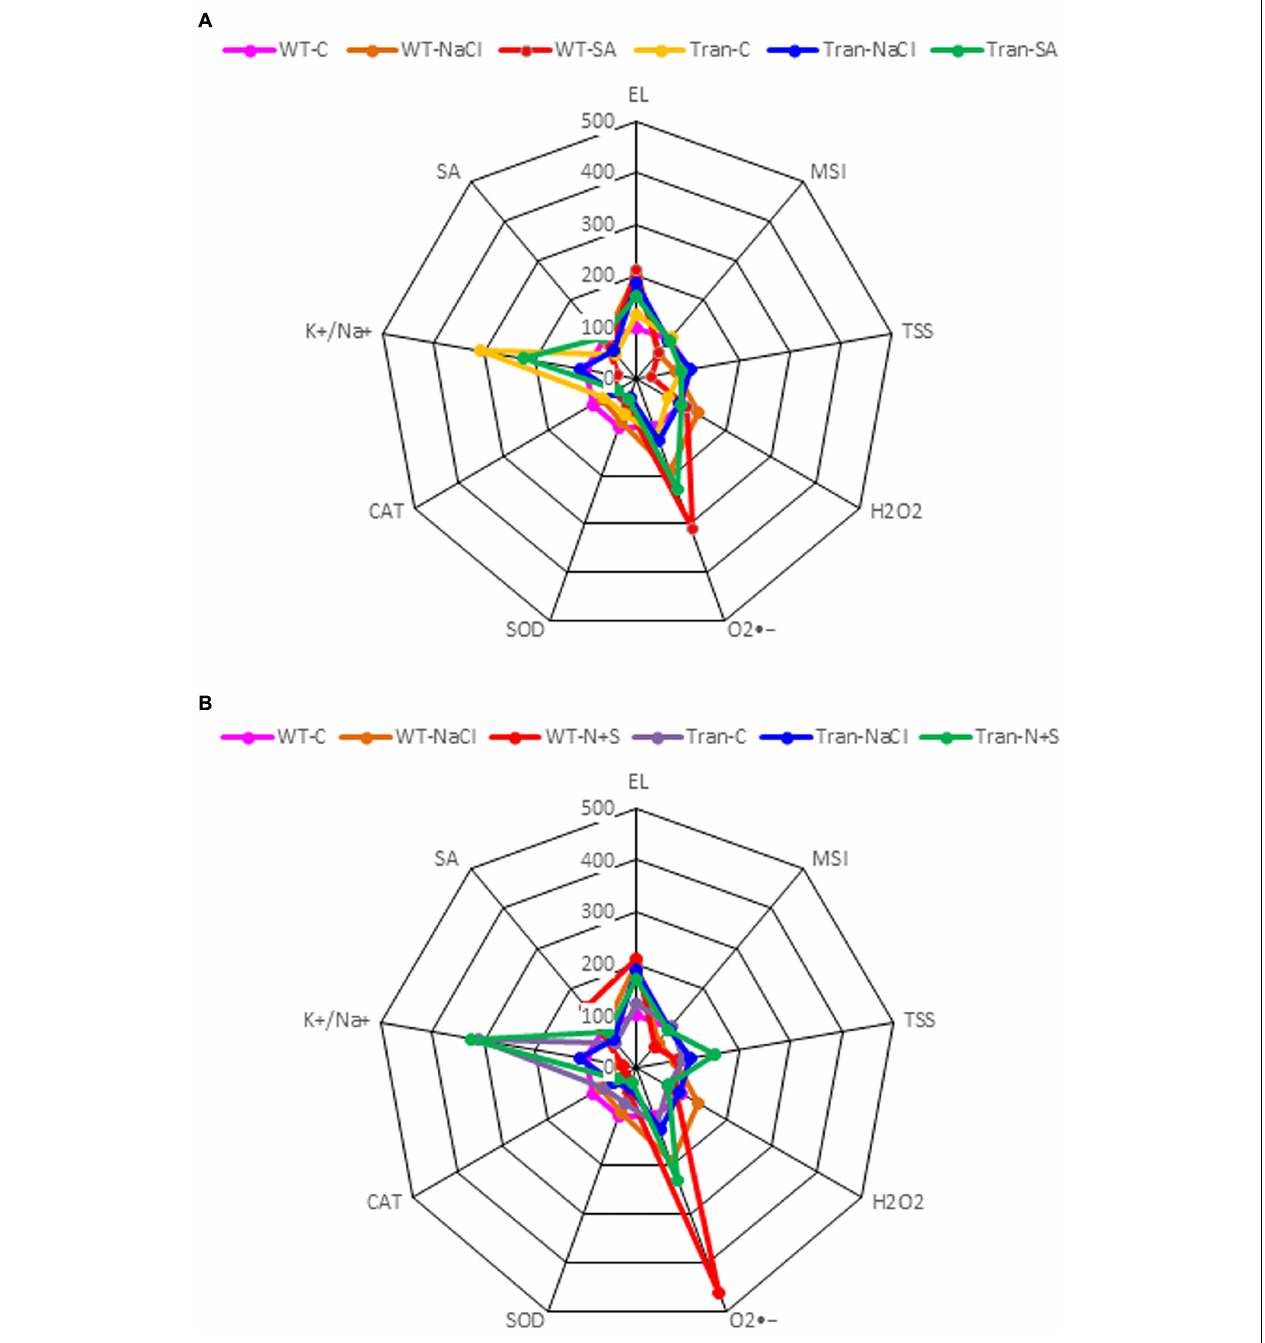
FIGURE 9 | The radar diagram built by comparing all the physio-biochemical parameters between WT and transgenic plants (average of three transgenic lines) (A) NaCl, SA and control, (B) NaCl, combinatorial (NaCl + SA) stress and control.